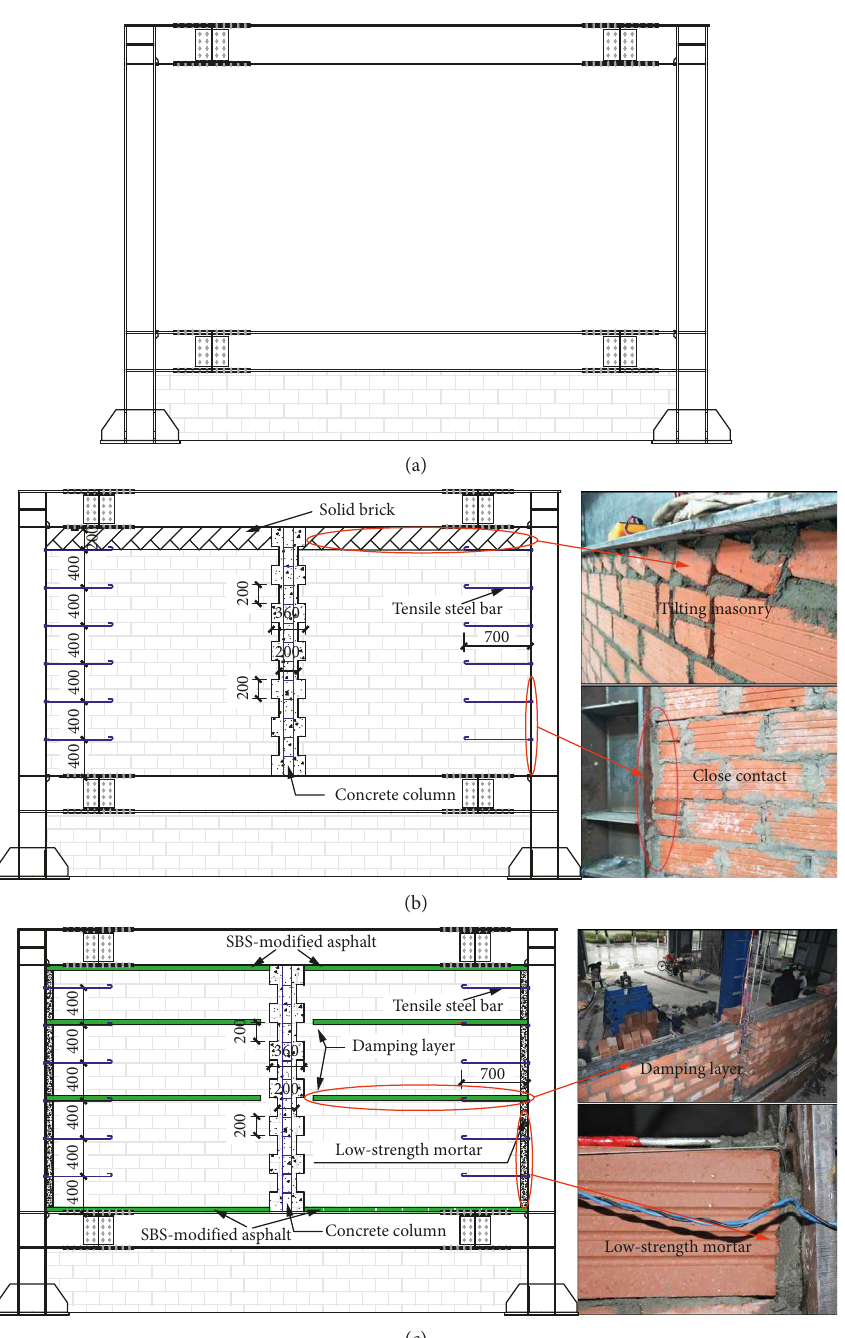
Figure 3: Schematic diagrams of damping layer structure and each mode structure. (a) UWF construction scheme. (b) Sample TMWF construction scheme. (c) PDWF construction